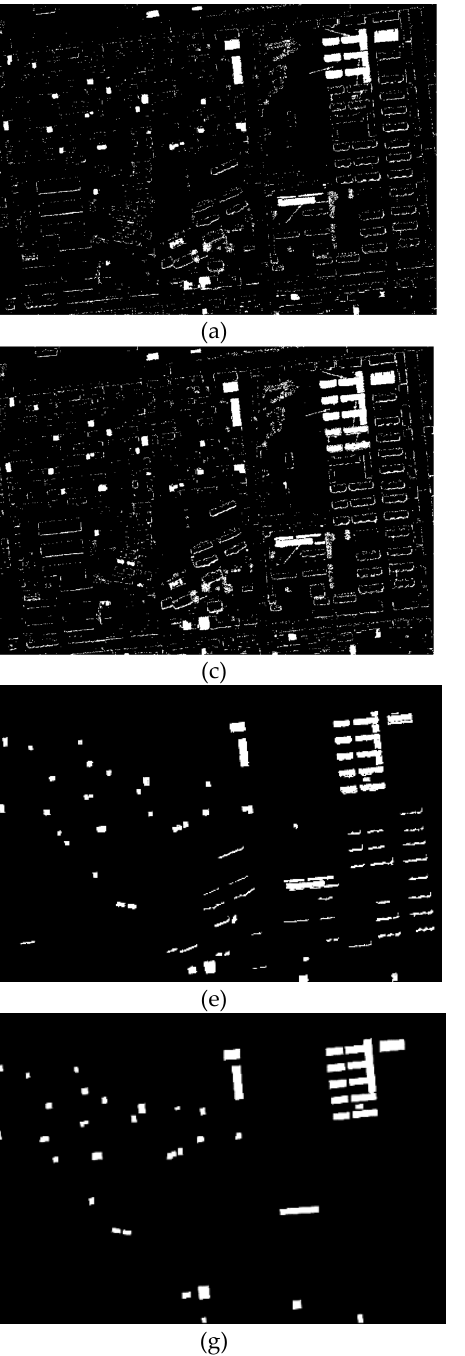
Figure 8. Building change detection results (white - building changes; black – other changes or non-changes) compared with popular CD methods: ( a ) CV, ( b ) MLSK, ( c ) MLSK + MRF, ( d ) FLICM, ( e ) CNN classification, ( f ) proposed method, and ( g ) reference